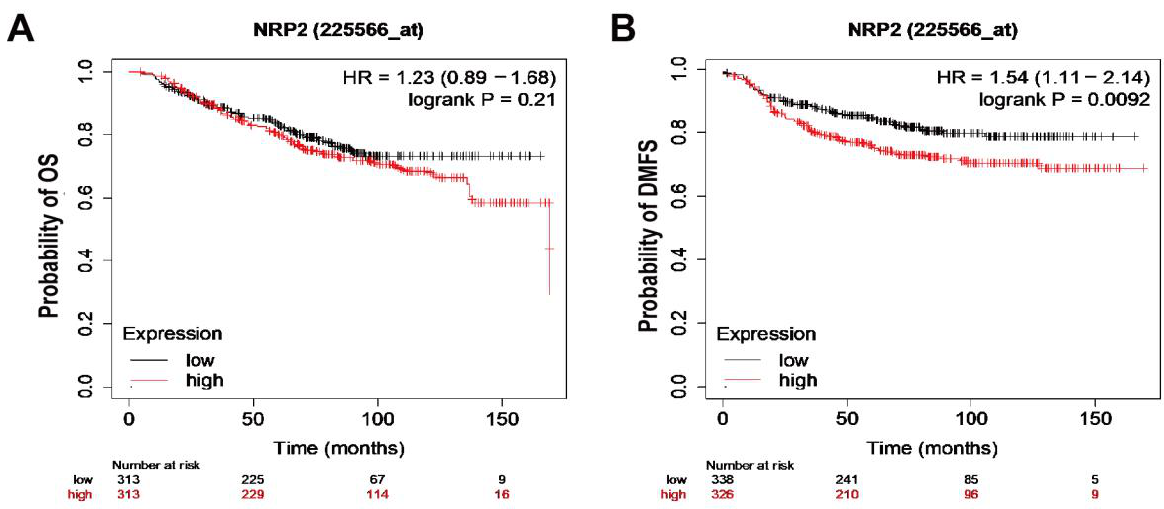
Figure 6. NRP2 expressions with respect to survival rates of breast cancer patients. ( A ) OS ( n = 626, number of events = 313, p = 0.21) and ( B ) DMFS ( n = 664, number of events = 326, p = 0.0092) for breast cancer patients with high NRP2 expression in the dataset, depicted on Kaplan–Meier